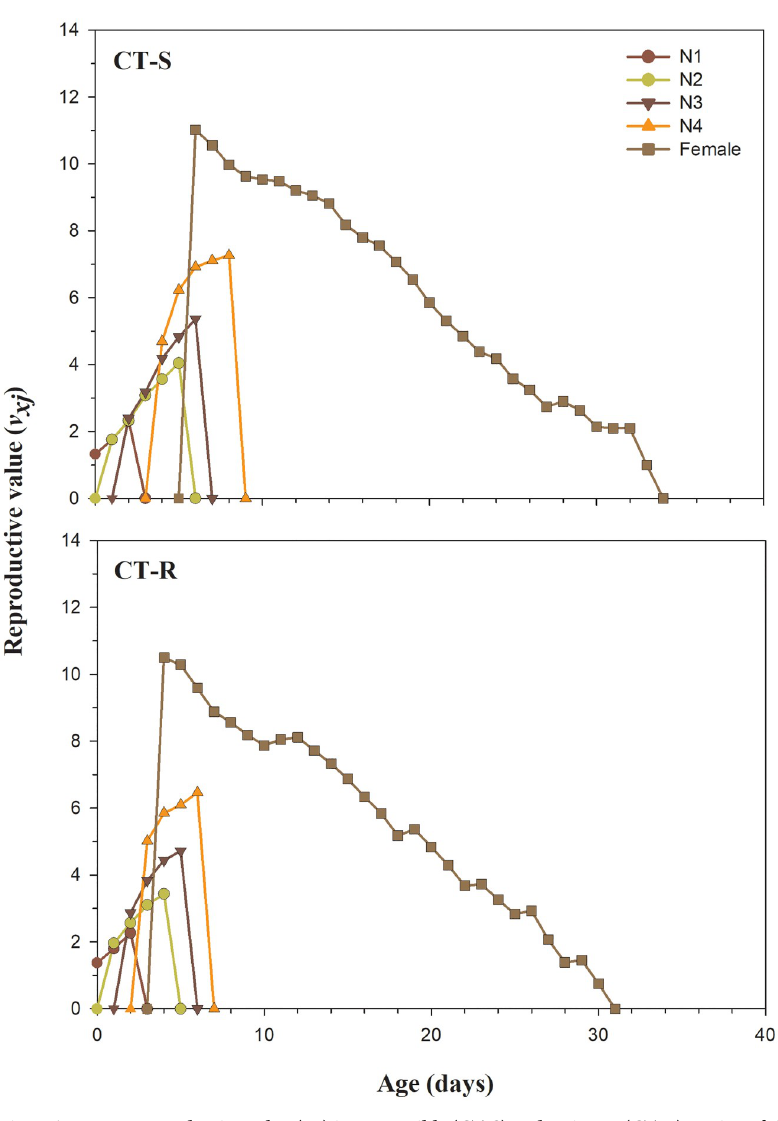
Fig 4. Age-stage reproductive value ( v